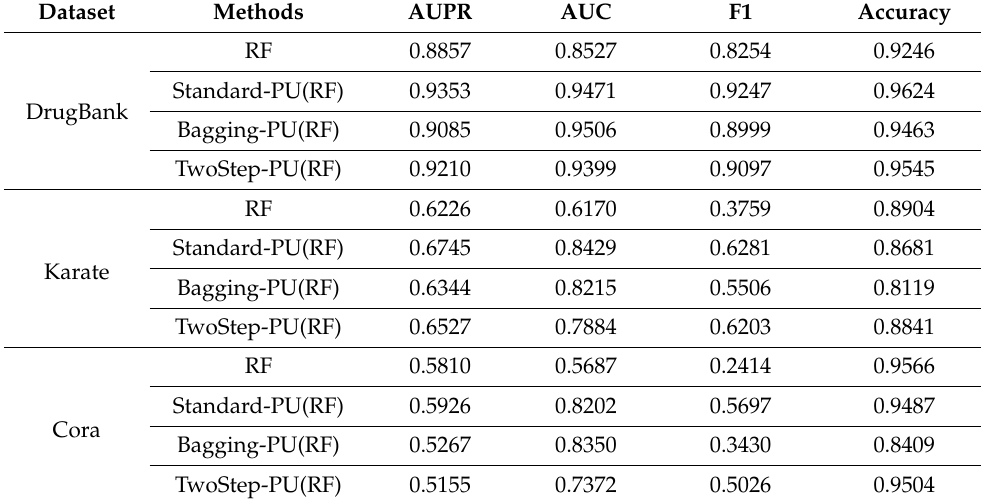
Table 4. The performance of different positive-unlabeled learning methods on three datasets.